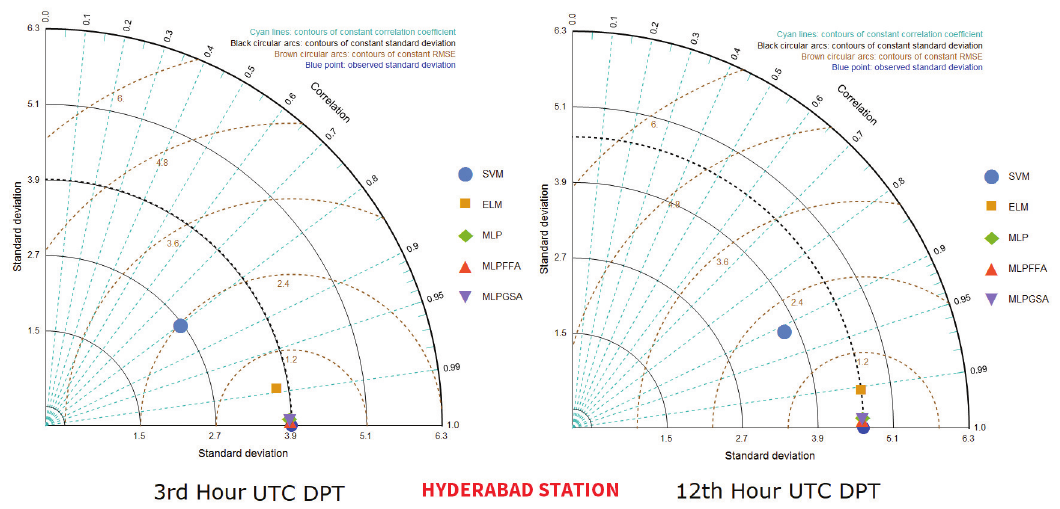
Figure 5. Taylor diagram for performance evaluation of the models with respect to Hyderabad station.